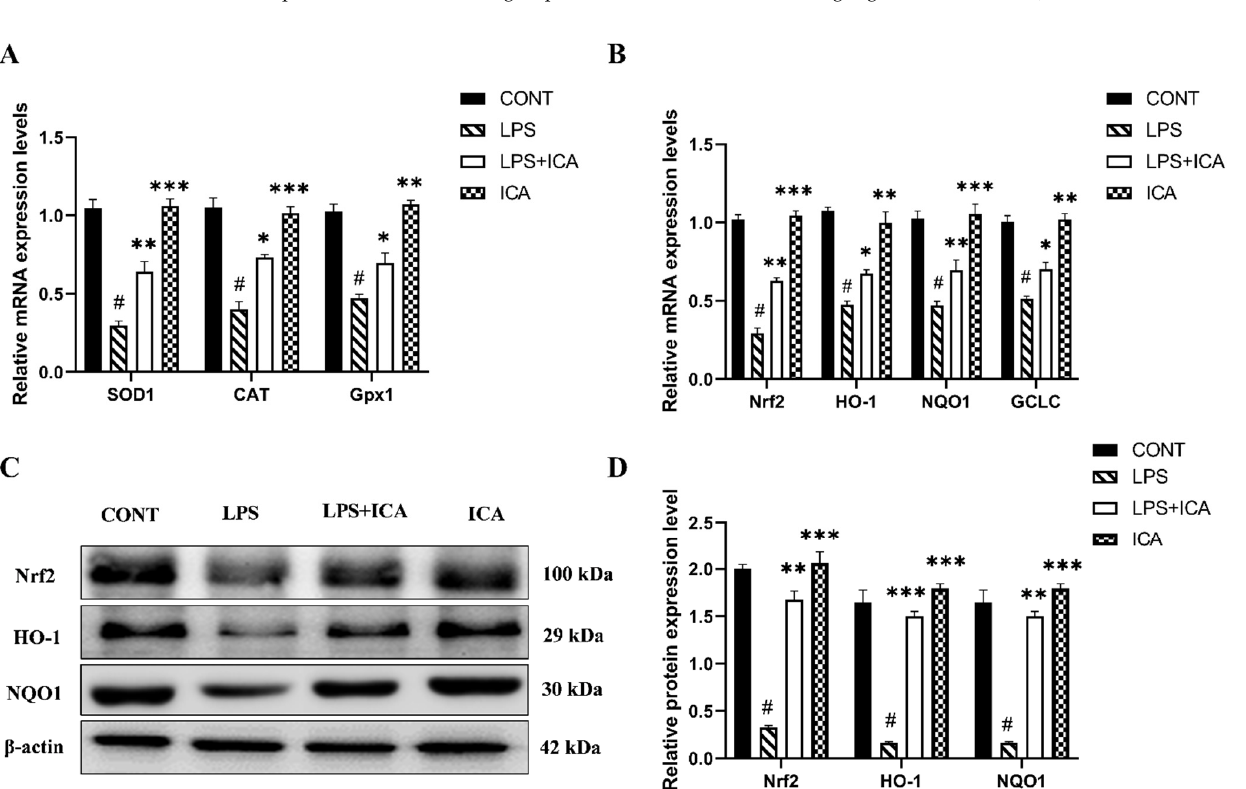
Figure 6. Influence of ICA treatment on LPS-induced oxidative stress-related genes via activation of Nrf2 pathway in murine uterus. ( A ) The relative mRNA expression levels of SOD1, CAT